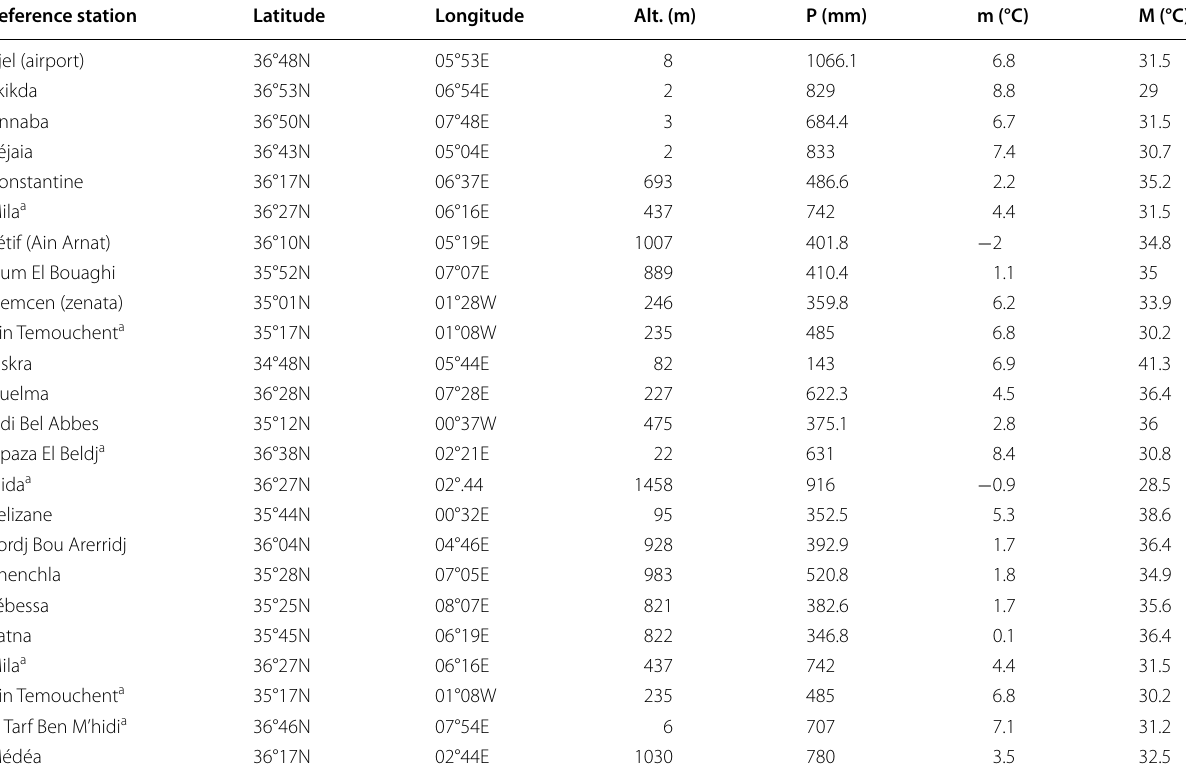
Alt altitude, P annual rainfall, M and m are the average maximum temperature of the hottest month and the average of the minimum of the coldest month,